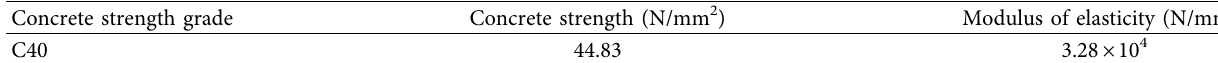
Table 4: Mechanical properties of the concrete.